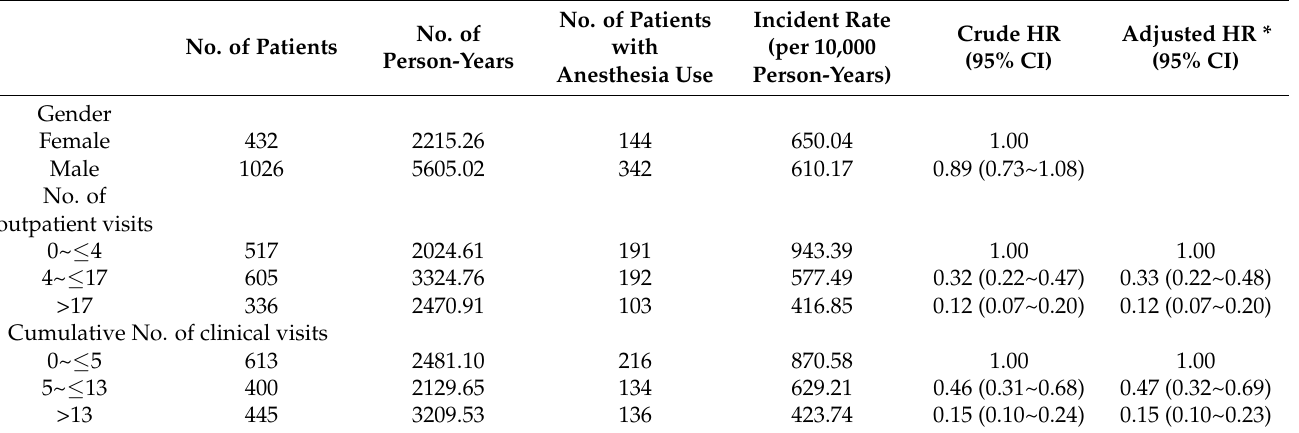
Table 4. Following clinical visit numbers in patients with asthma onset after general anesthesia (GA) exposure.